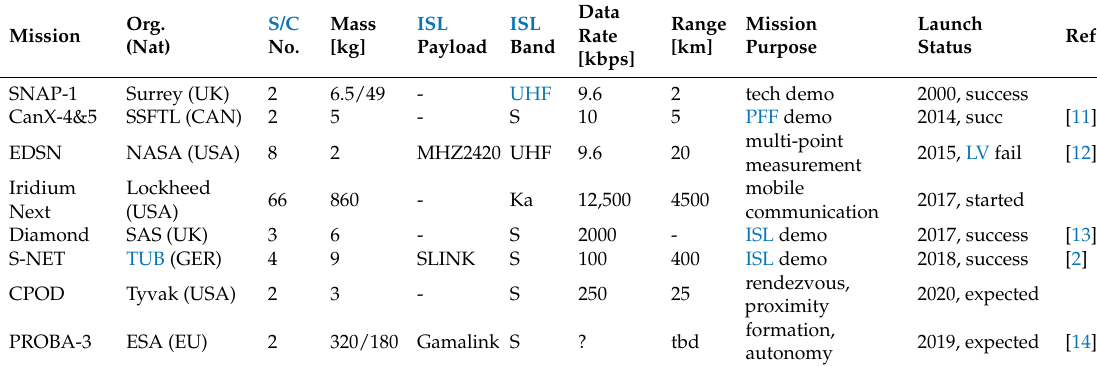
Table 2. Selected list of notable past and future small satellite ISL missions and parameters.